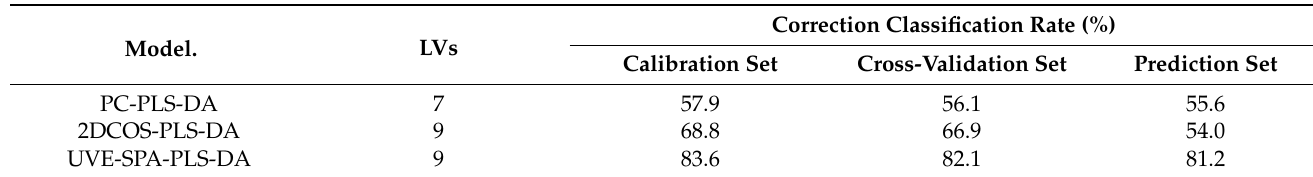
Table 4. Performance of multi-spectral PLSR models using selected wavelengths.